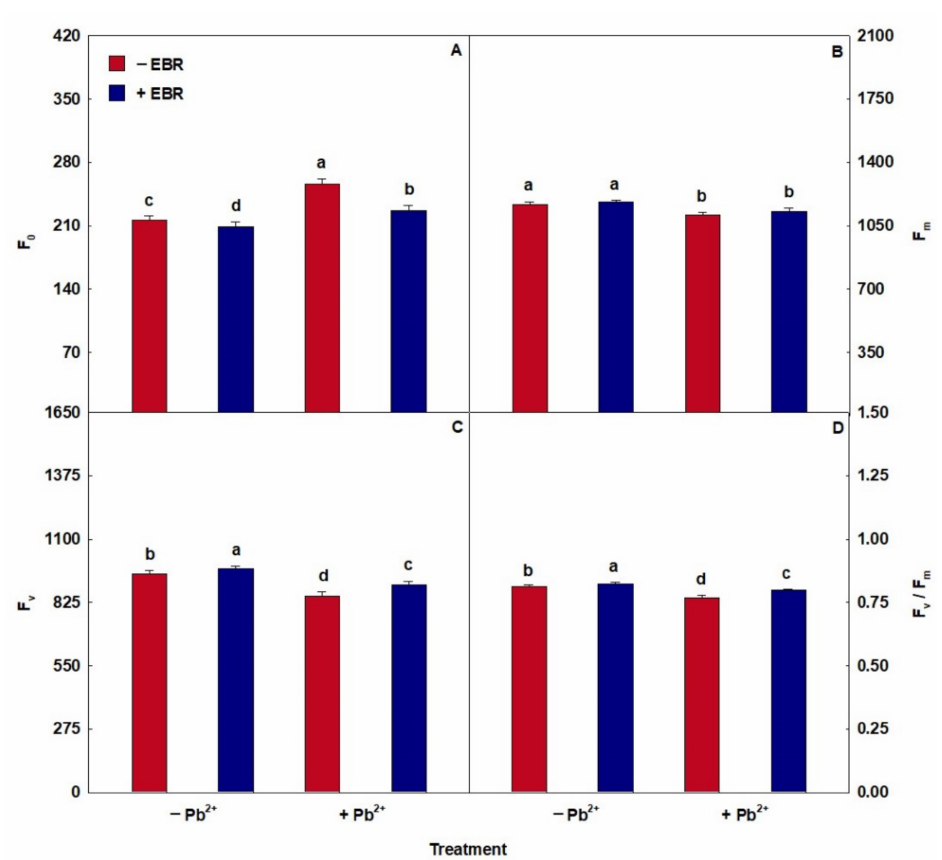
Pb = lead; EBR = 24-epibrassinolide; Chl a = chlorophyll a ; Chl b = chlorophyll b ; Total chl = total chlorophyll; Car = carotenoids; Φ PSII = effective quantum yield of PSII photochemistry; q P = photochemical quenching coefficient; NPQ = nonphotochemical quenching; ETR = electron transport rate; EXC = relative energy excess at the PSII level; ETR/ P N = ratio between the electron transport rate and net photosynthetic rate; P N = net photosynthetic rate; E = transpiration rate; g s = stomatal conductance; C i = intercellular CO 2 concentration;